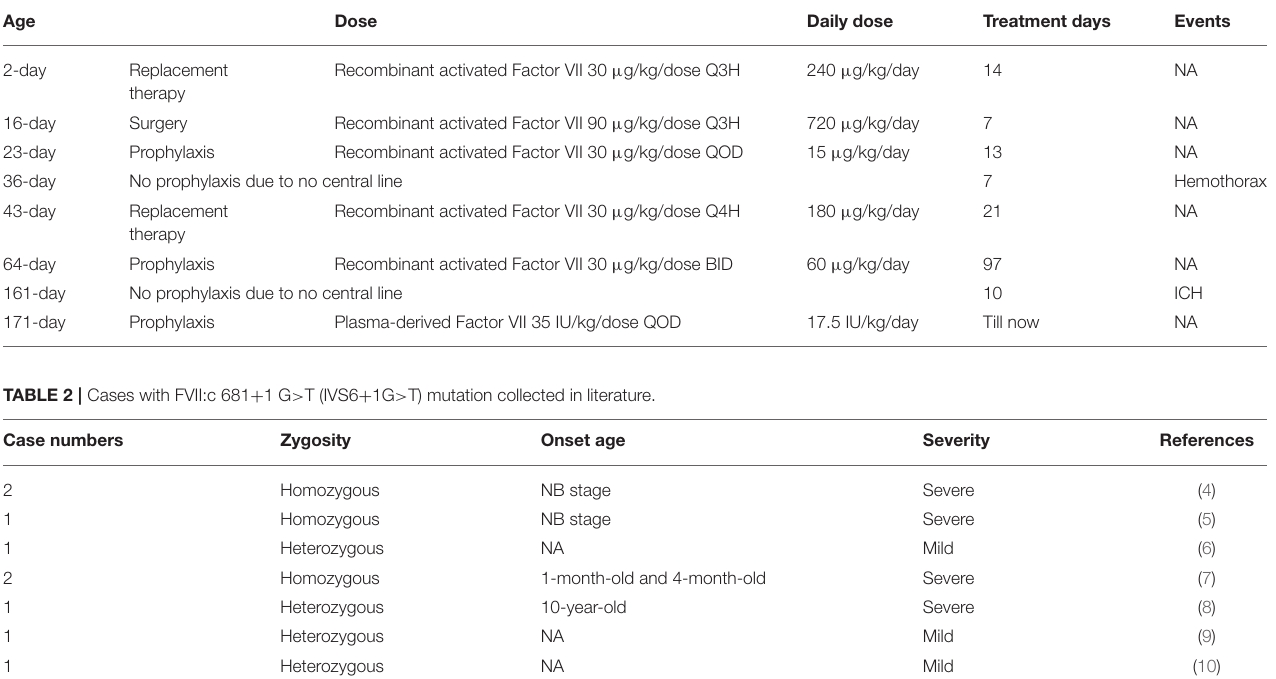
TABLE 1 | Treatments and investigation results during the hospital course.